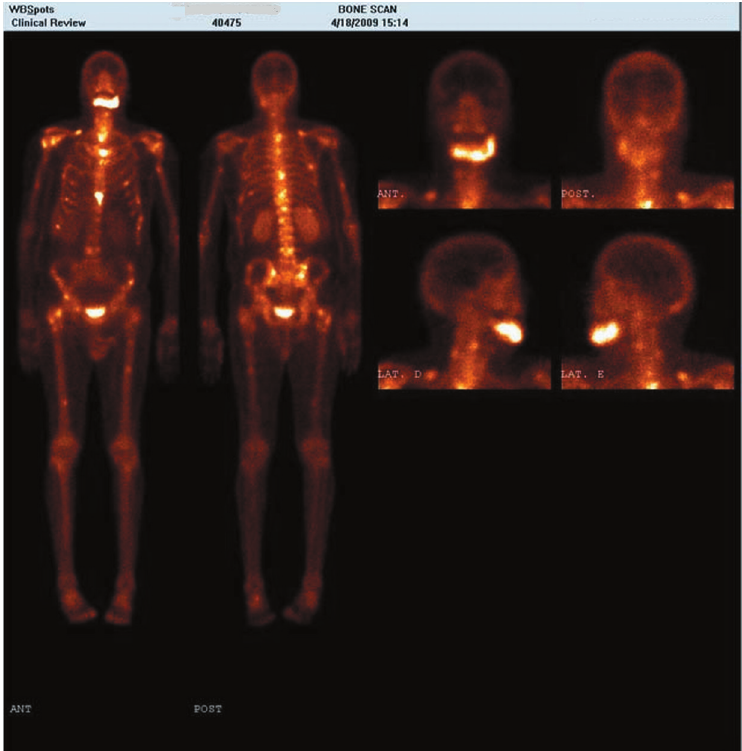
Figure 4- Whole-body bone scintigraphy, increased uptake of the radiocontrast agent observed in the mandibular region, right clavicle and scapula, humerus, ribs, spine, sternum, hip bone and femur (right/left). Source: Oral and